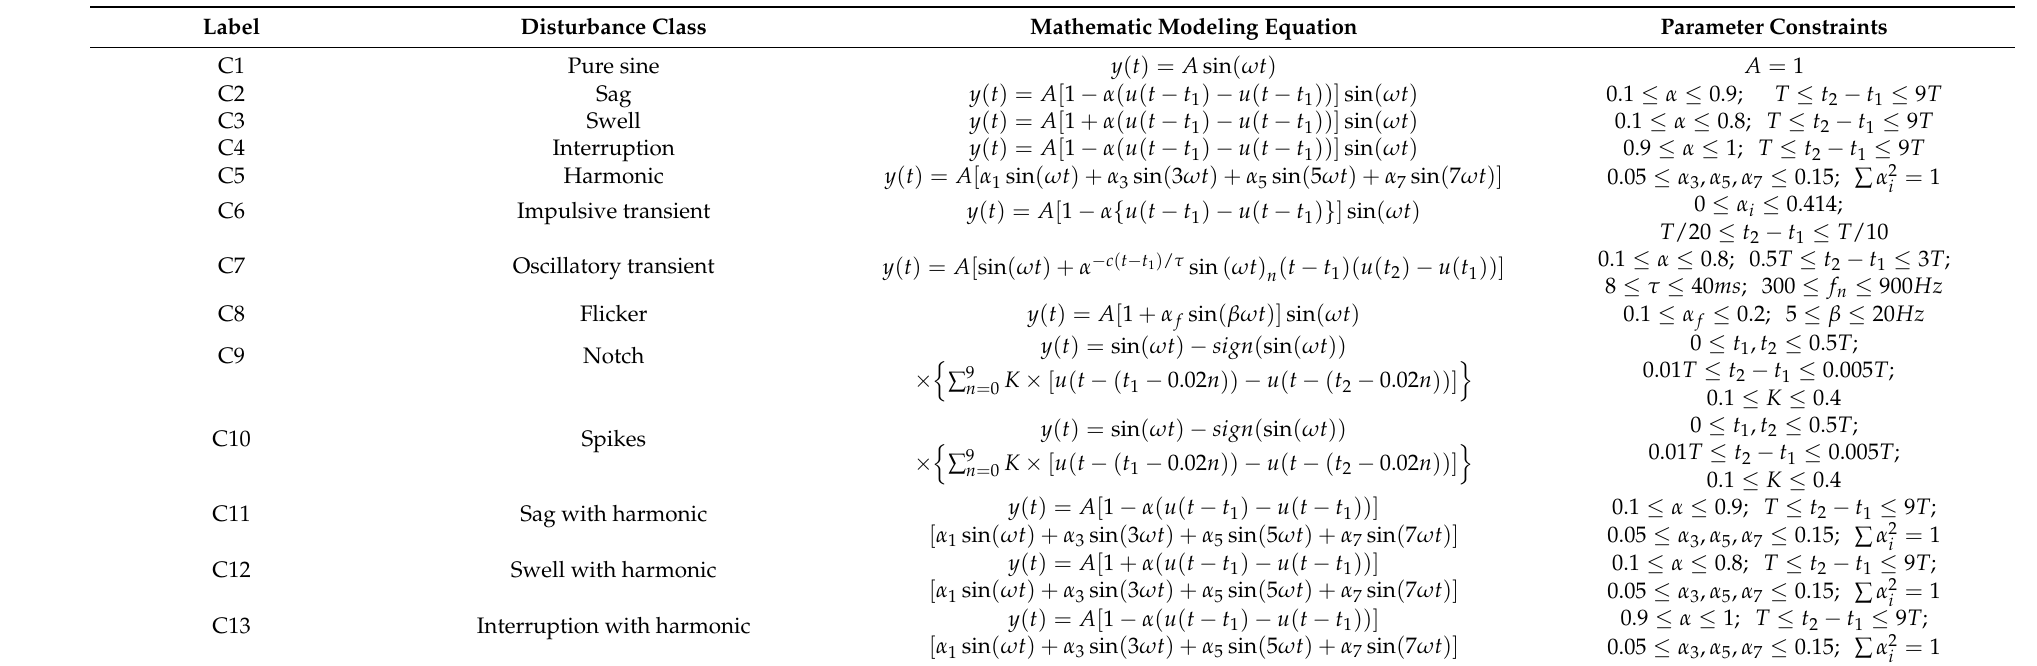
Table 1. Mathematical equations of power quality disturbances (PQDs)